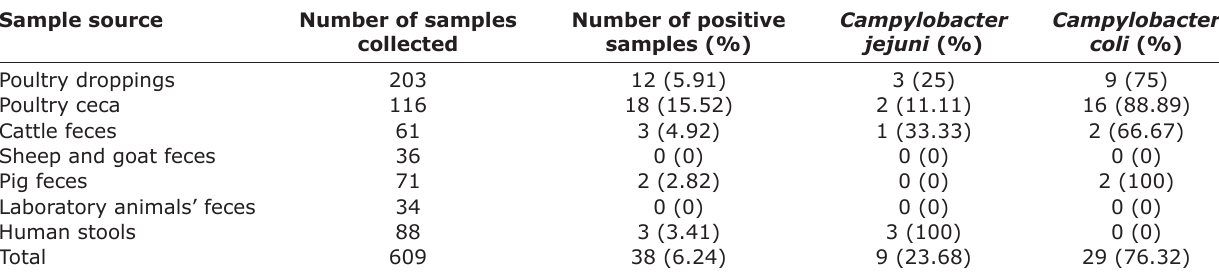
Figure-5: Gel electrophoresis of polymerase chain reaction (PCR) product pld A (913 bp), Lane M: 100 bp ladder, Lane 1 - Escherichia coli , Lanes 2-15: pld A PCR product. Table-1: Distribution of Campylobacter isolates across various samples.